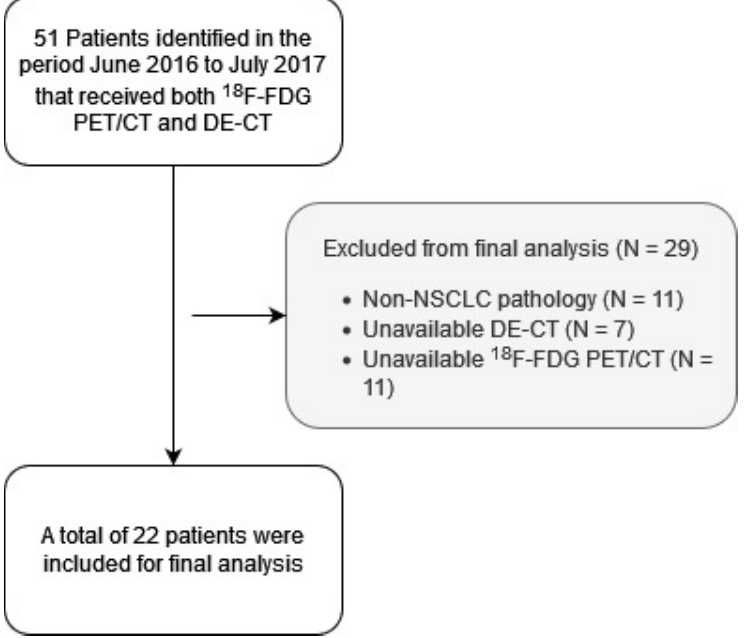
Figure 1. Flowchart showing patient inclusion/exclusion. Table 1. Patient demographics including age, sex, days between PET and SCE-CT scans, tumor size, pathology, clinical stage and T stage. We found a positive correlation between SUV max and Iodine max (R = 0.64, p = 0.002) and a strong positive correlation between metabolic tumor volume (MTV) and total iodine content (R = 0.91, p < 0.0001), similar to previous studies (Figure 2) [11,17].